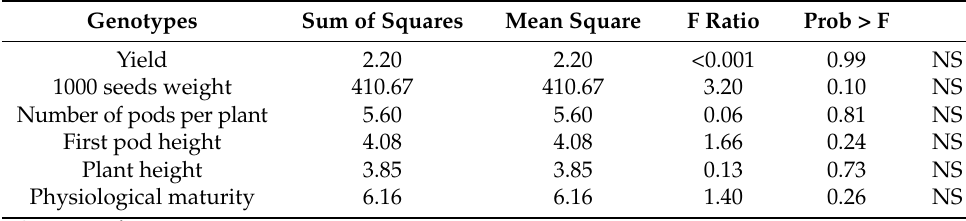
Table 3. The analysis of variance of agronomic